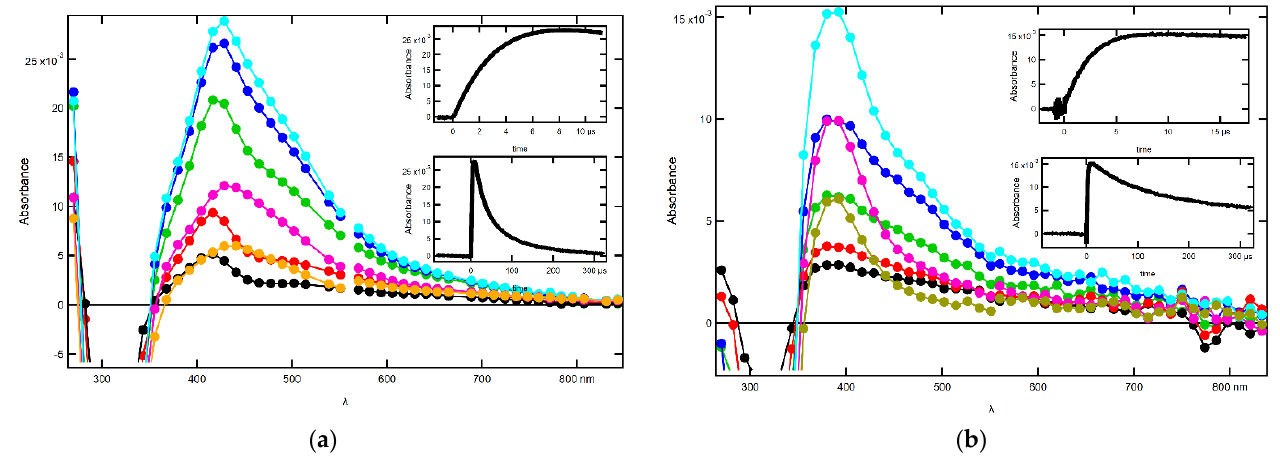
Figure 2. Transient absorption spectra recorded in N 2 O-saturated unbuffered aqueous solutions containing 0.05 mM of 2-SeU ( a ) at pH 4, 500 ( ), 1 μ s ( ), 3 μ s ( ), 5 μ s ( ), 8 μ s ( ), 50 μ s ( ), and 100 μ s ( ) after electron pulse. Insets: time profiles representing growth (upper) and decay (bottom) of transient absorption at λ = 440 nm ; ( b ) at pH = 10, 300 ns ( ), 500 ns ( ) 1 μ s ( ), 2 μ s ( ), 10 μ s ( ), 100 μ s ( ), and 300 μ s ( ) after electron pulse. Insets: time profiles representing growth (upper) and decay (bottom) of transient absorption at λ = 390 nm.